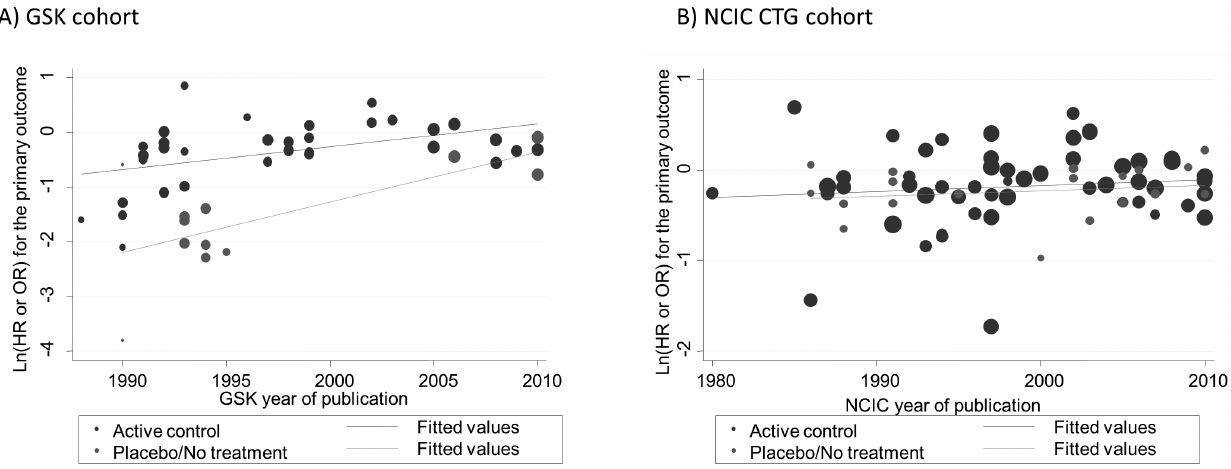
Figure 12. Meta-regression of effect of time (year of publication), choice of active control and sample size on the magnitude effect in National Cancer Institute Canada Clinical Trials Group (CTG) cohort of trials (A) and GlaxoSmithKline (GSK) cohort (B). None of the variables were statistically significant in NCIC CTG cohort of trials (R 2 = 2 0.68%). In GSK cohort sample size showed no statistical significant association with the results (p=0.08) while year (p=0.048) and the choice of comparator (p , 0.000) were statistically associated with the observed results in GSK cohort. These two variable accounted for about 72% of the observed variation in the results (R 2 =71.69%). In general, the effect size was closer to 1 (ln HR=0) when the active comparator was employed.